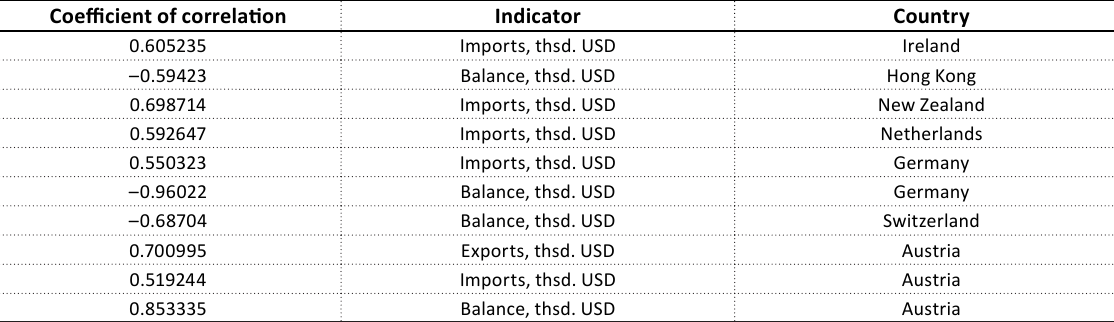
Table 5. Correlation of the dependence of the export indicator to the UK from Ukraine with the export, import, and balance indicators of the investigated offshore